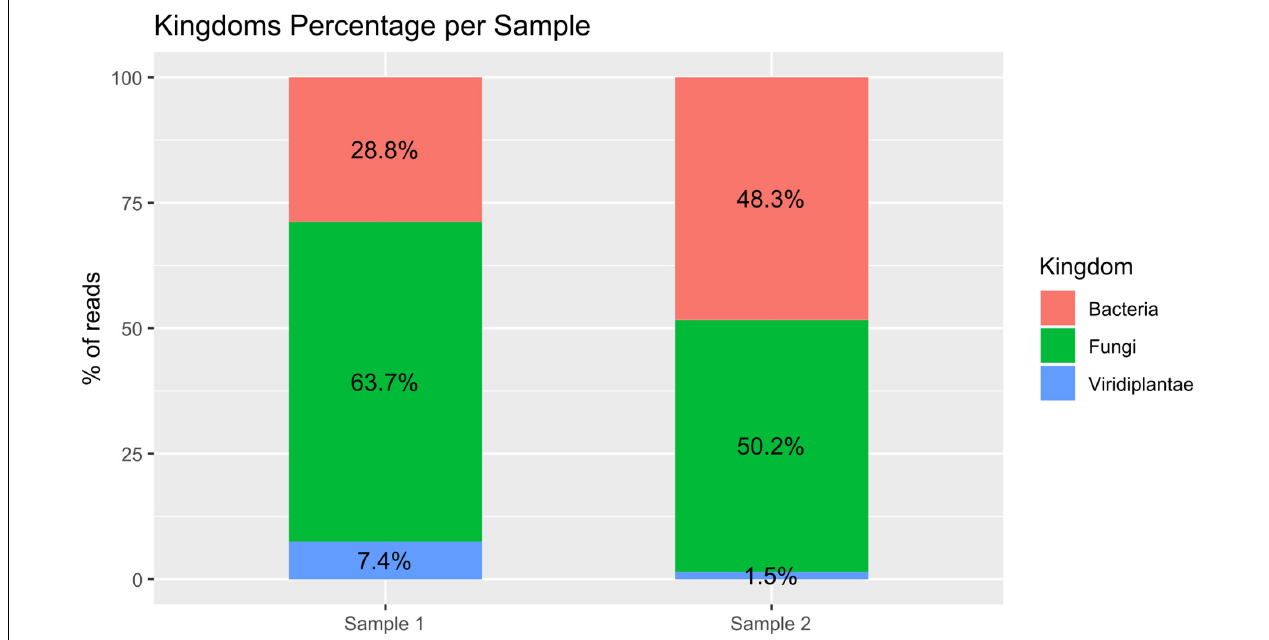
FIGURE 2 | Bar plot of percentage of the three analyzed kingdoms for both samples. The reads assigned to the bacteria kingdom were 28.8 and 48.3% respectively for Samples 1 and 2; the reads assigned to the fungi kingdom were 63.7 and 50.2% respectively for Samples 1 and 2; and the reads assigned to the Viridiplantae kingdom were 7.4 and 1.5% respectively for Samples 1 and